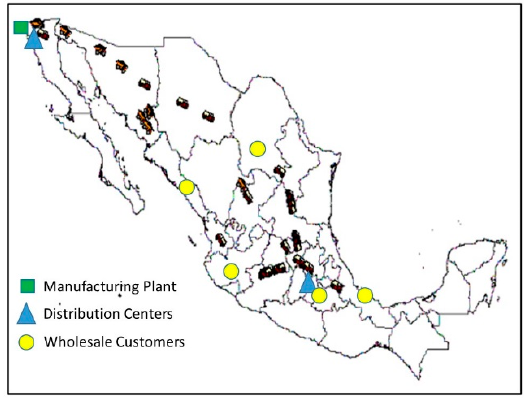
Figure 2. Simulation Model Representation.